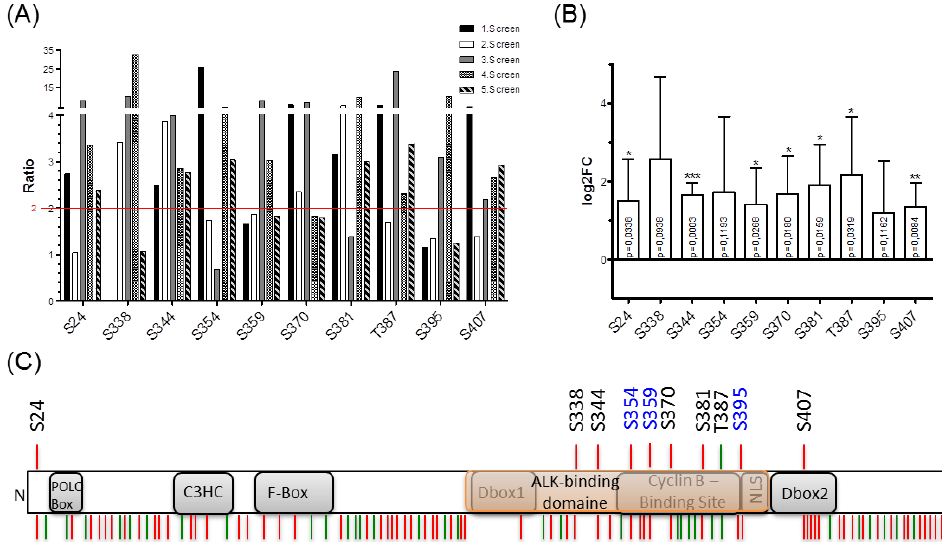
Figure 2. Mass spectrometry-based proteomic phosphosite analysis identified specific NPM-ALK induced NIPA phosphosites. ( A ) Overexpressed FLAG-tagged NIPA in 293T cells was immunoprecipitated and used for proteomic phosphosite analysis: Serine residues S24, S338, S344,